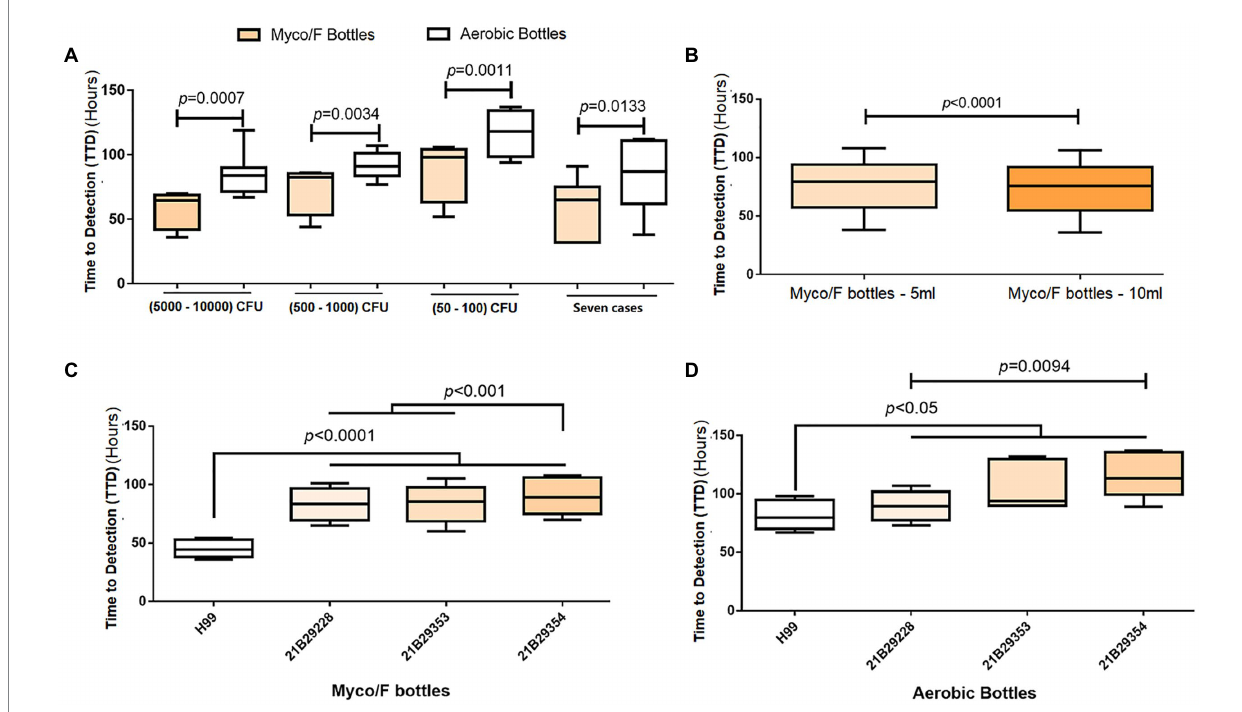
FIGURE 3 Evaluation of different blood bottles, sample volumes, and clinical isolates. (A) Comparison of the time-to-detection (TTD) between Aerobic/F and Myco/F bottles as well as various inoculation concentrations. Eight replicates for each inoculation concentration. (B) Comparison of the TTD between 5-and 10-mL samples in Myco/F bottles. Twelve replicates for each volume (5- or 10-mL). (C) Comparison of the TTD among four clinical C. neoformans isolates inoculated in Myco/F bottles. Twelve replicates for each isolate. (D) Comparison of the TTD among four clinical C. neoformans isolates inoculated in Aerobic/F bottles. Six replicates for each